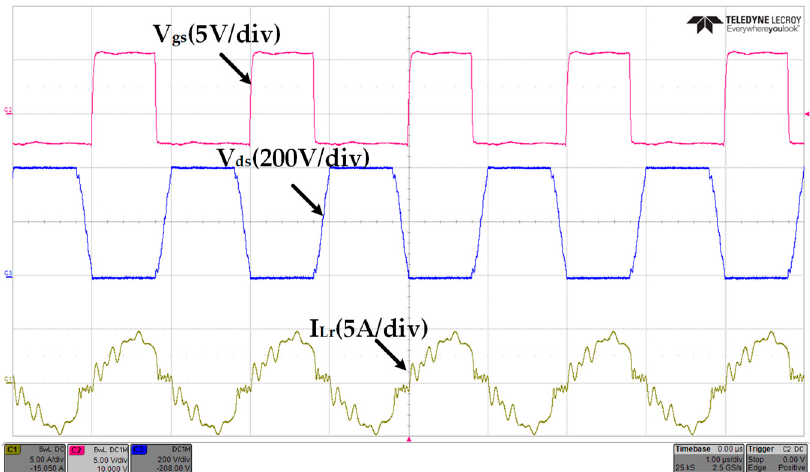
Figure 18. Experimental waveforms for the converter at full load.